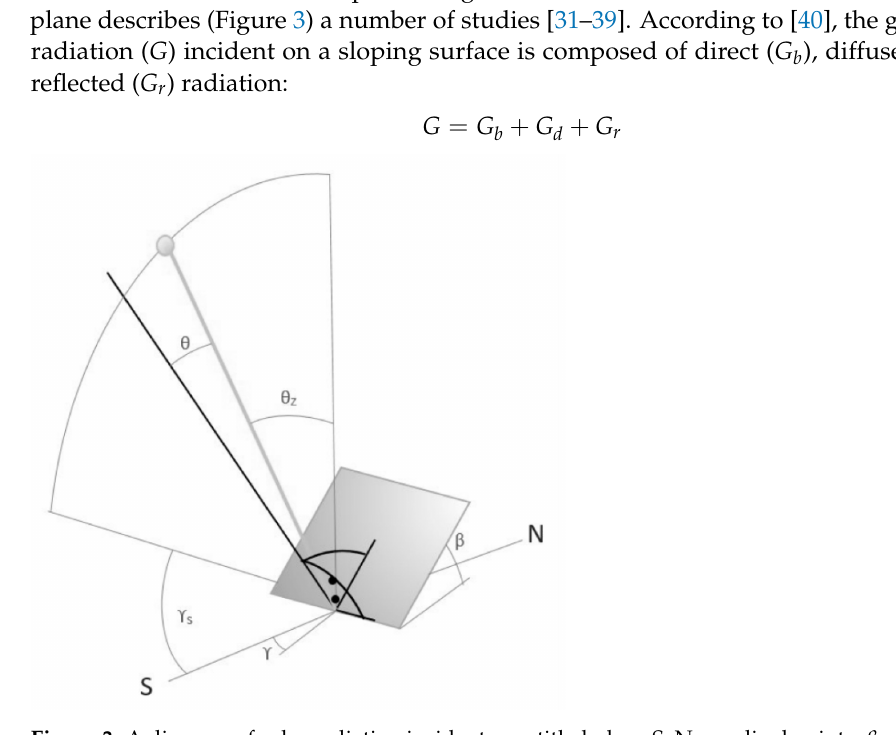
Figure 3. A diagram of solar radiation incident on a titled plane S, N– cardinal points, β —angle of the inclined plane, γ —plane azimuth angle, γ s —solar azimuth angle, θ —incidence angle, and θ z —solar zenith